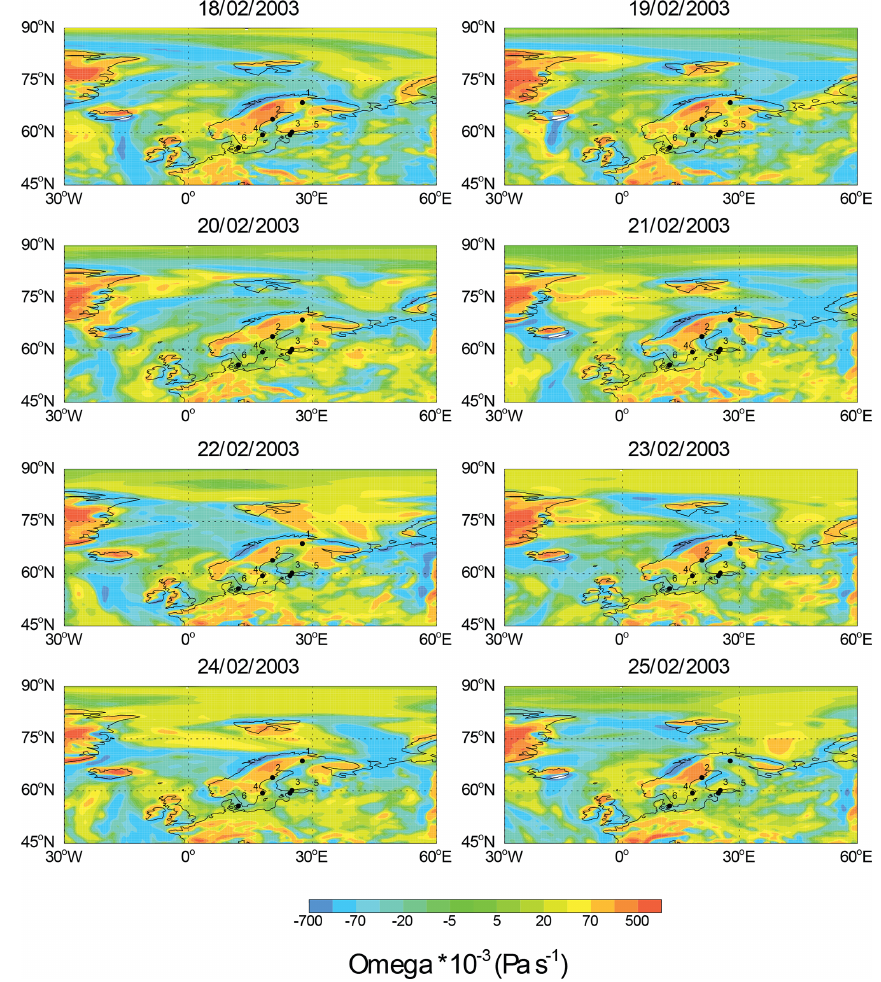
Figure 13. MERRA-2 daily mean vertical pressure velocity (omega) at 940hPa during 18–25 February 2003. The dots indicate the locations of the sampling sites: 1 = Ivalo, 2 = Umeå, 3 = Helsinki, 4 = Kista, 5 = Harku, 6 =